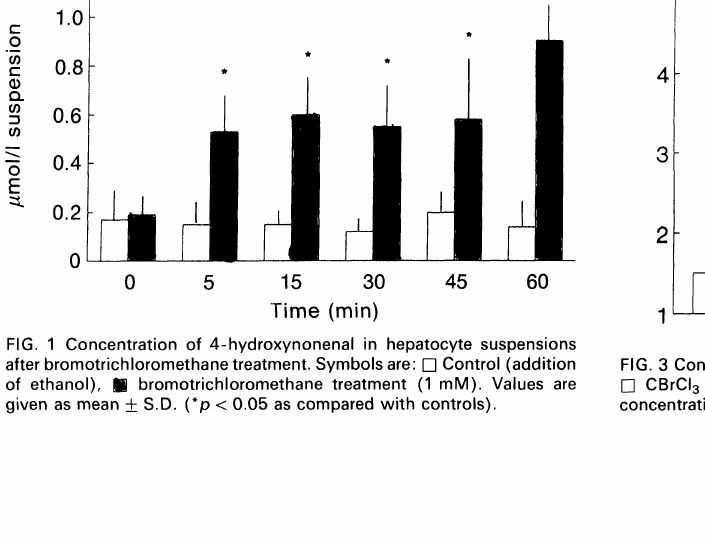
FIG. 3 Concentration ratios of aldehydes after 60 min of incubation with [] CBrCI3 and [] CCI4 (see Reference 13) compared with the initial concentration in the same